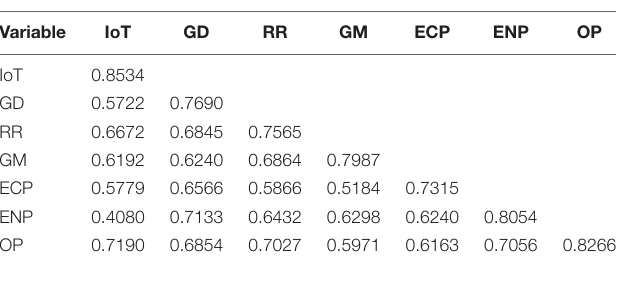
TABLE 5 | KMO and Bartlett’s